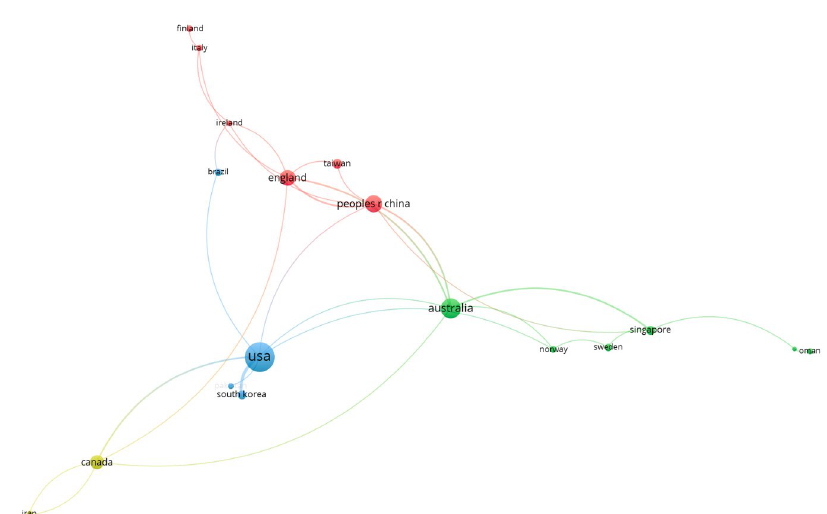
Fig. 4. The network visualization of co-authorship by countries, 2005–2022 (up to 7 September). Source: developed by the